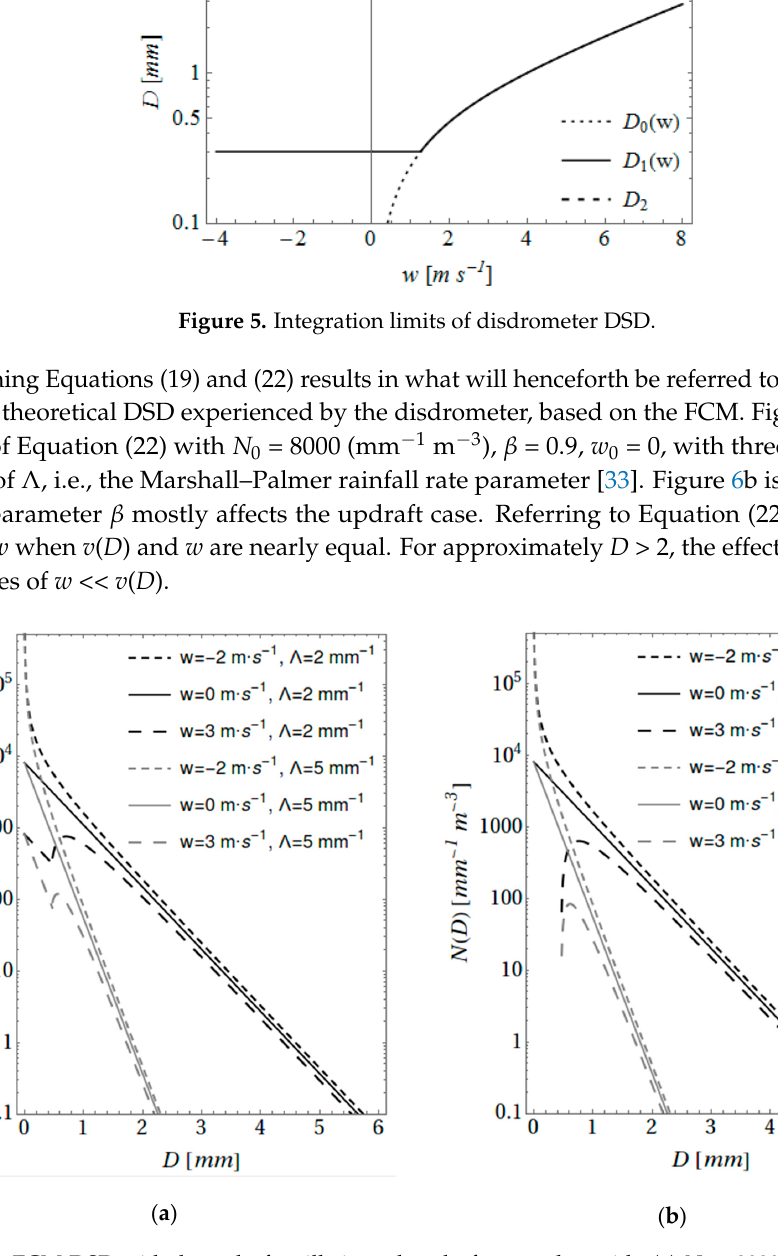
Figure 6. FCM-DSD with downdraft, still air, and updraft examples, with: ( a ) N 0 = 8000 (mm − 1 m − 3 ), β = 0.9, and w 0 = 0; ( b ) N 0 = 8000 (mm − 1 m − 3 ), β = 1, and w 0 = 0.